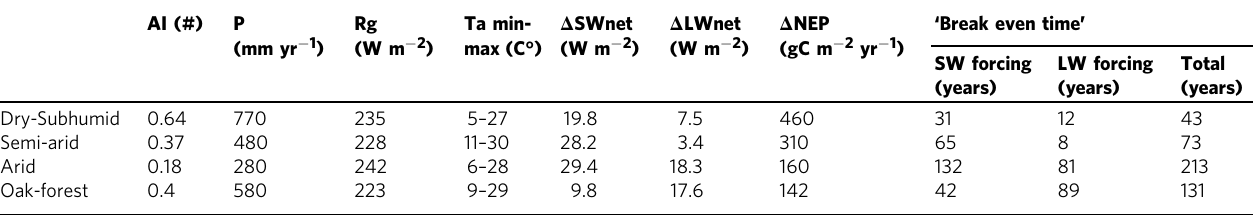
Table 1 Differences between forested (F) and adjacent non-forested (NF) for the three pine sites and one oak site in radiation budget and carbon stock.